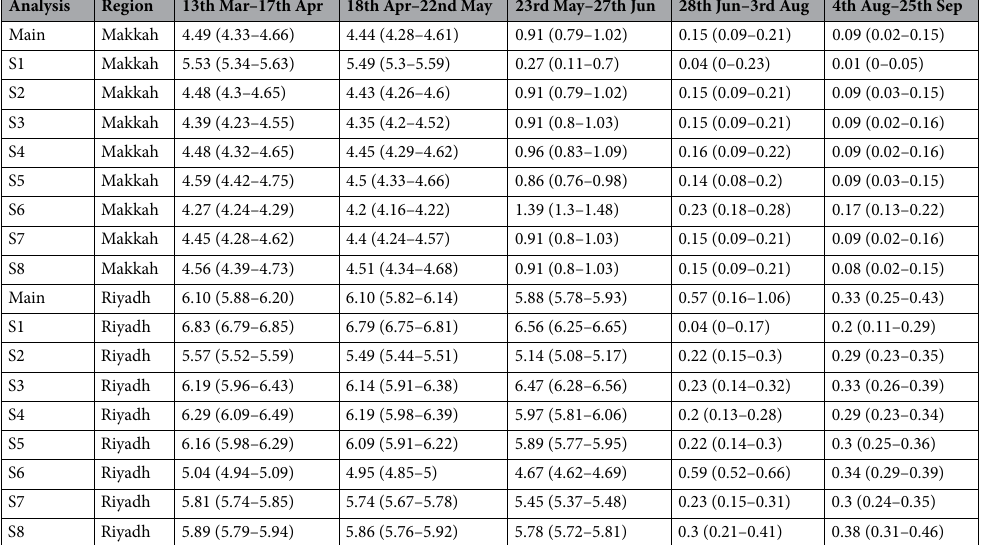
Table 7. Sensitivity analysis of estimated effective reproduction number R t for Makkah and